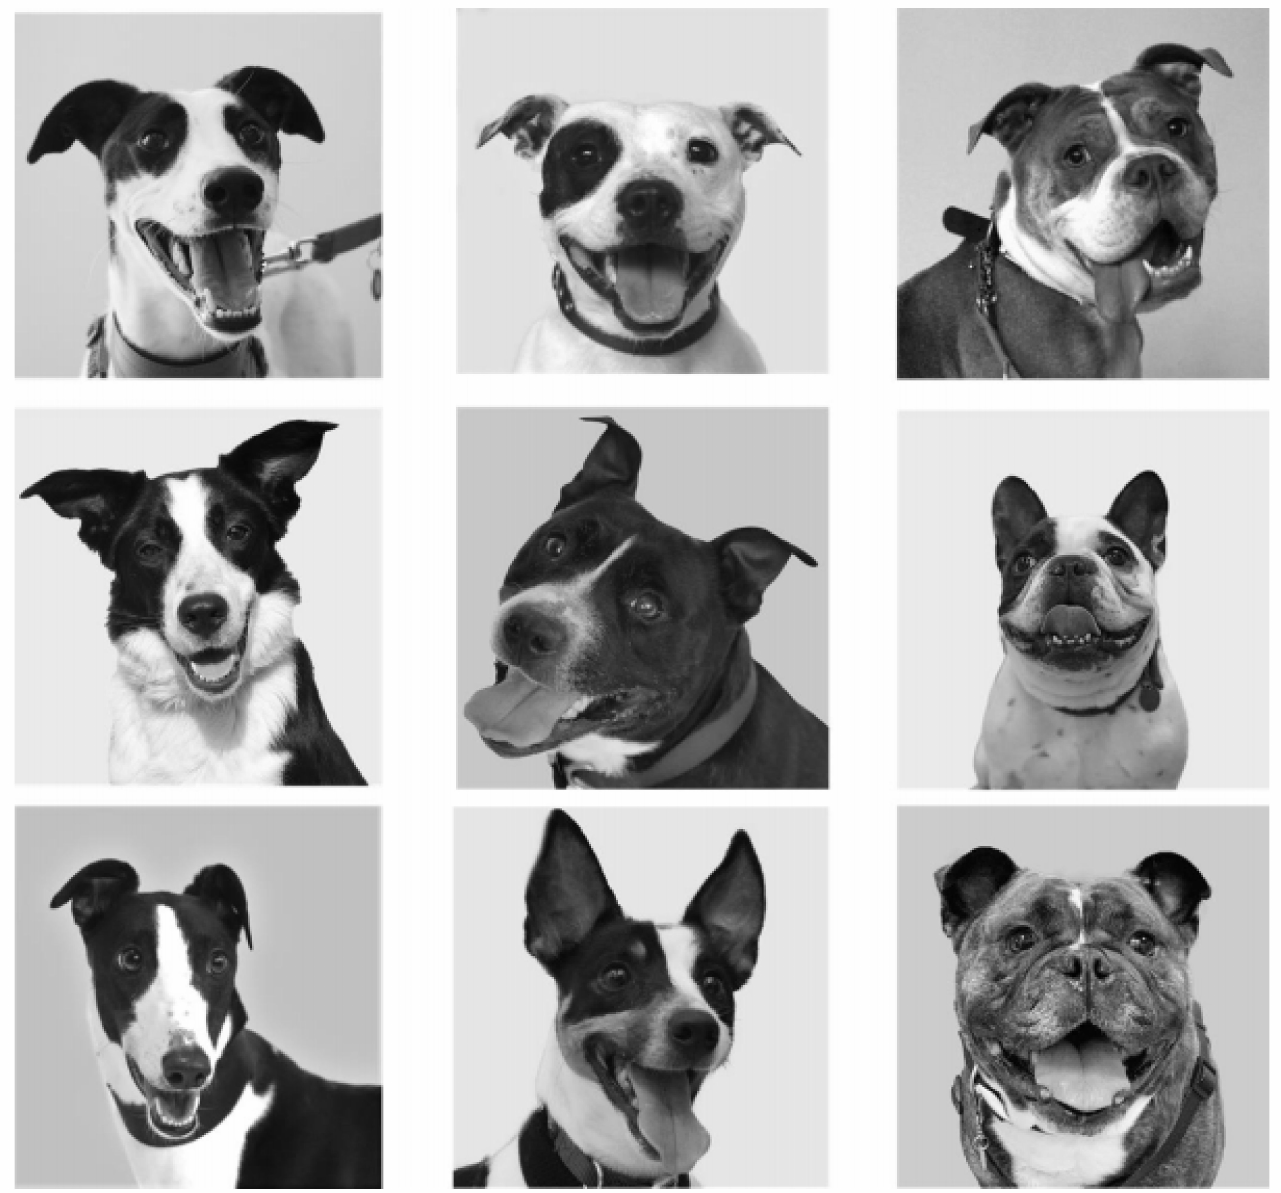
Figure 1. Final matched images of dogs of varying CI groups. Columns show images presenting, from left to right, DC, MC and BC